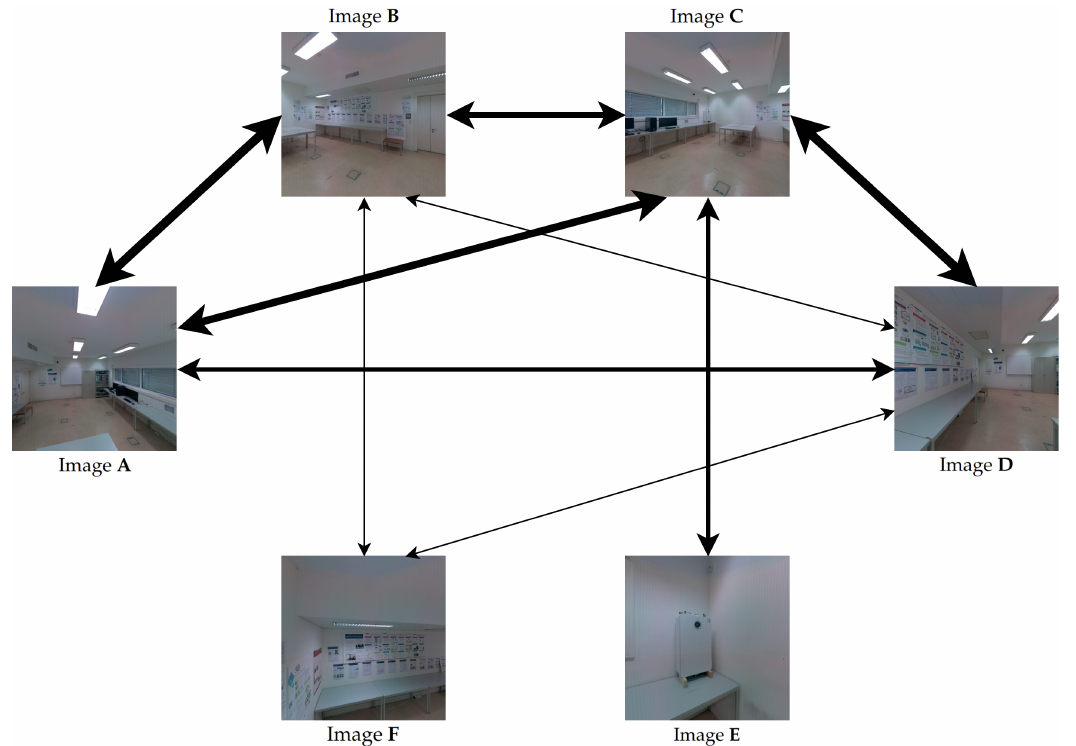
Figure 4. Example of a color-correction weighted graph. The nodes are represented by the indi- vidual images, the edges are represented by the arrows, and the thickness of the edges represents their